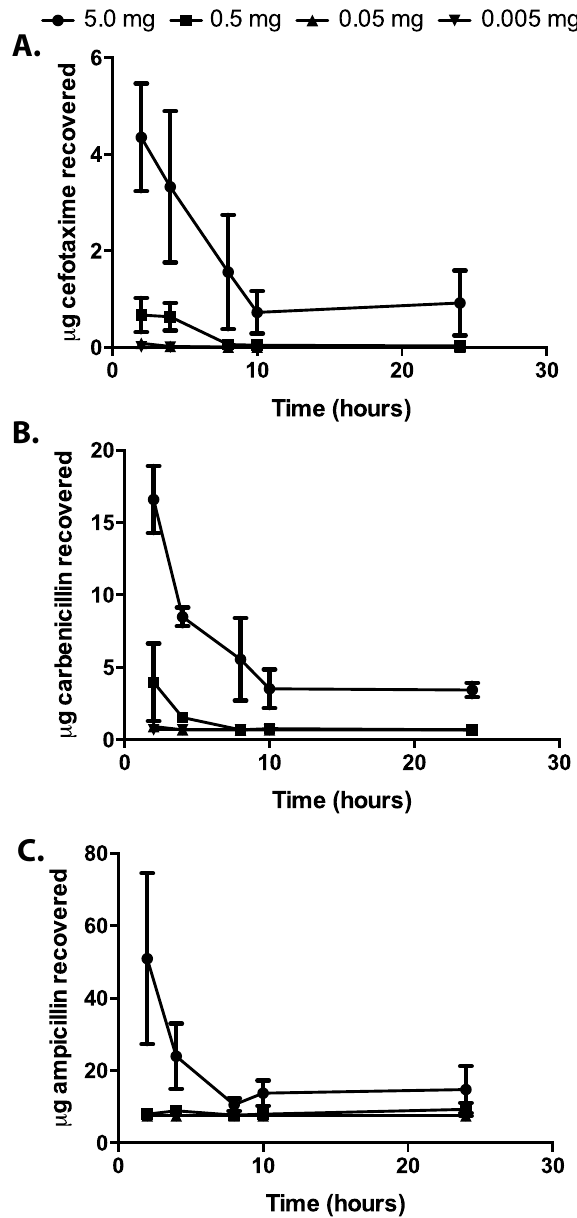
Figure 1. Beta lactam recovery from B. dubia roaches over time. Cefotaxime ( A ), carbenicillin ( B ), or ampicillin ( C ) was injected into B. dubia roaches at the dose indicated. At the designated time points, hemolymph was extracted and was mixed with an anticoagulant. This material was dispensed onto a disk of sterile filter paper which was placed onto TSA containing E. coli that had been spread-plated. Following incubation, zones of inhibition were measured; to estimate the amount of antibiotic recovered, the values for the zones of inhibition generated from the recovered hemolymph were compared to a standard curve.